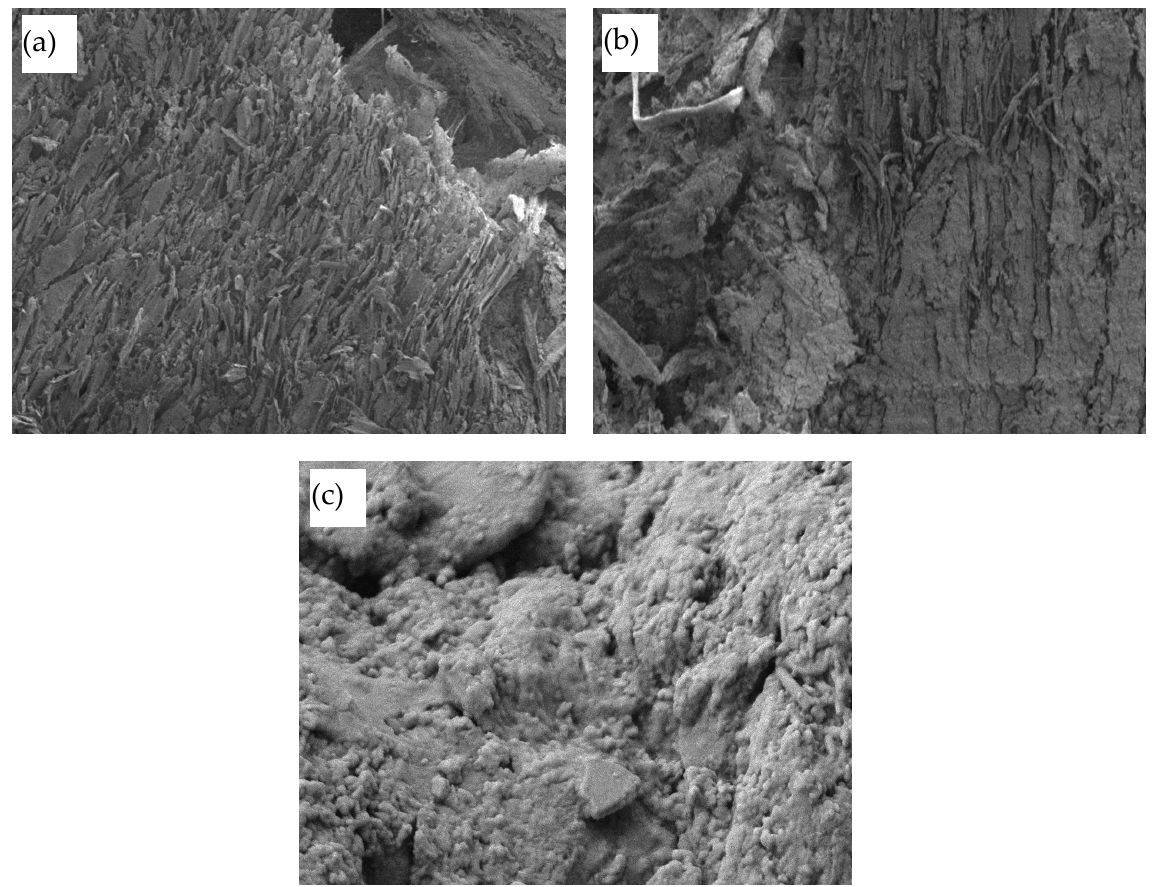
Figure 9. Structure of the biocomposite: ( a ) hardened sapropel on the rough surface of wood waste particle, magnification × 300; ( b ) hardened sapropel on the flat surface of wood waste particle, magnification × 300; ( c ) distribution of hardened sapropel on the surface of wood waste particles magni- fication ×5000.